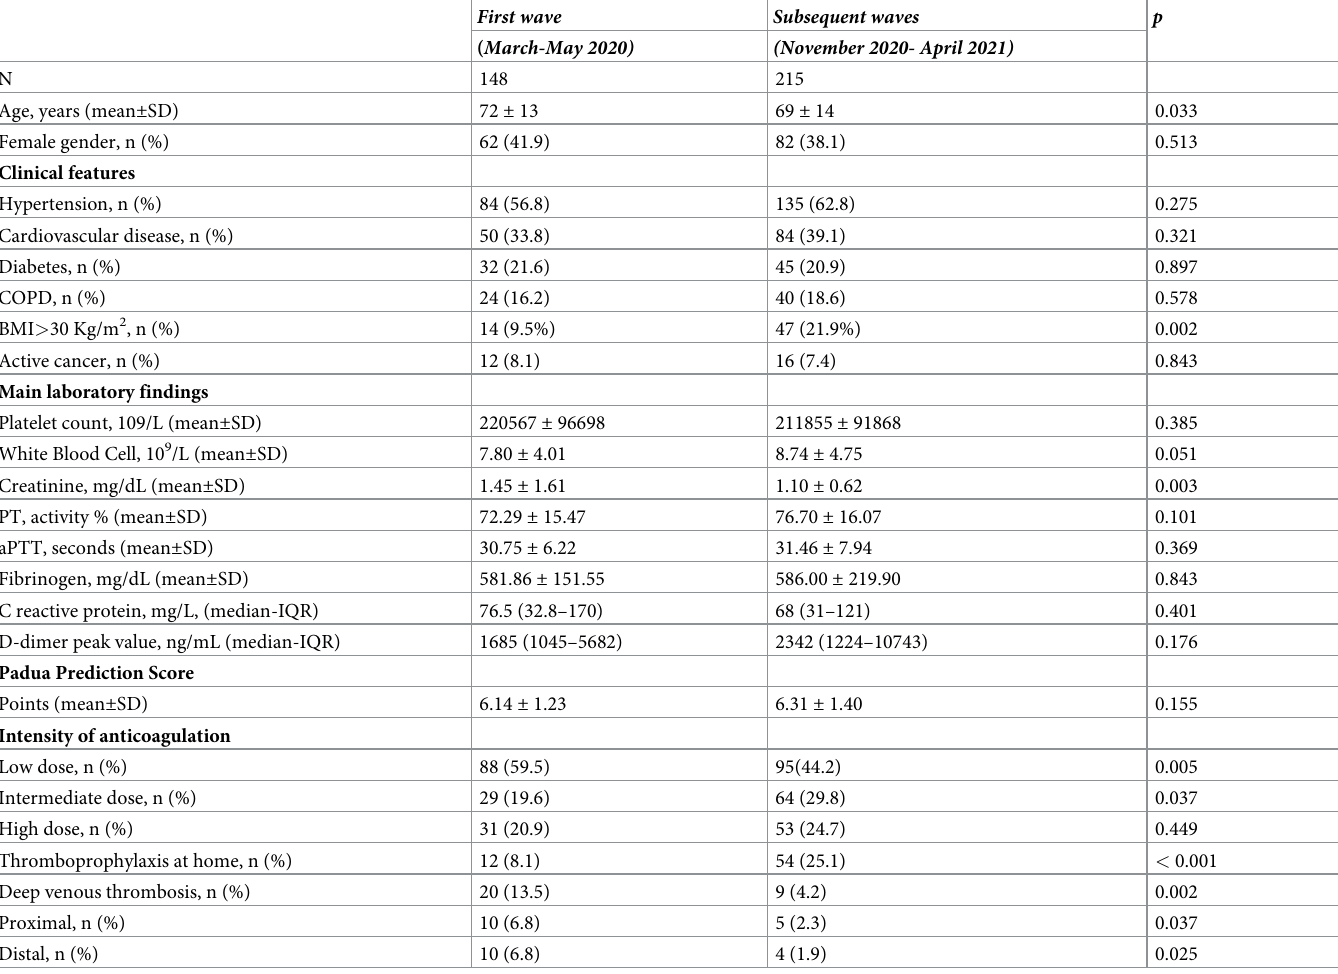
Table 2. Demographic, clinical characteristics and laboratory findings and outcomes of patients with e without DVT. First